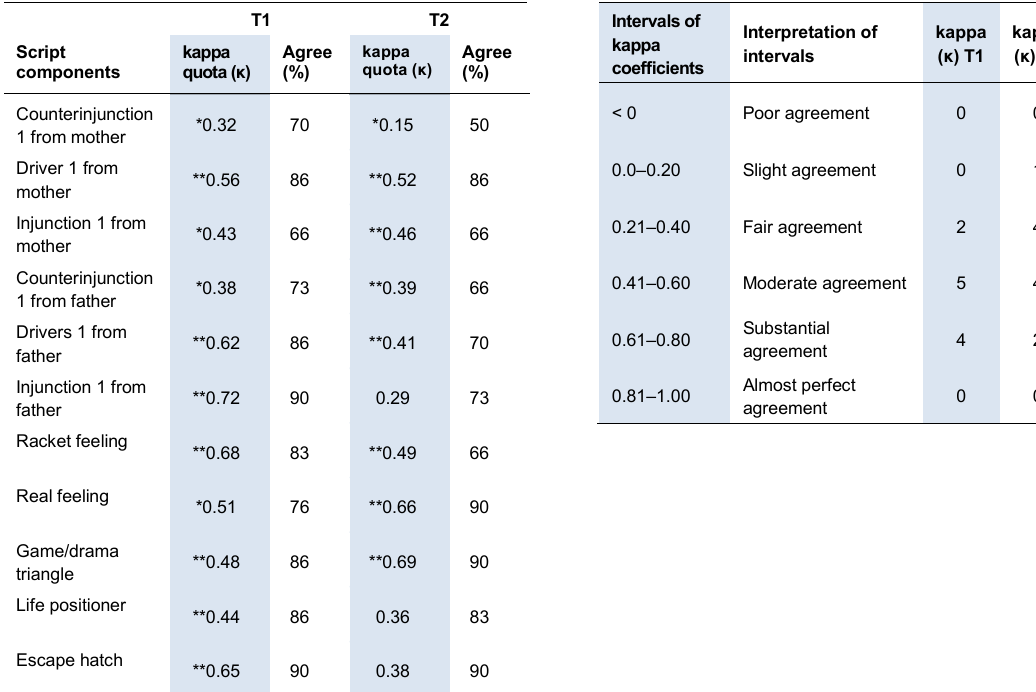
Table 5: Distribution of kappa coefficients for 11